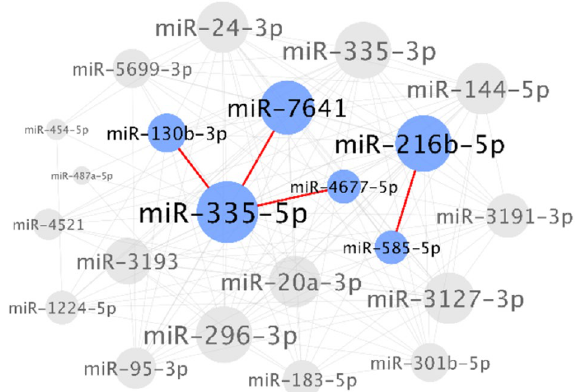
Figure 2. Synergistic survival analysis of 22 candidate miRNAs indicated that only 6 miRNAs (blue circles) had significantly synergistic effects when combined in 4 pairs (red lines).